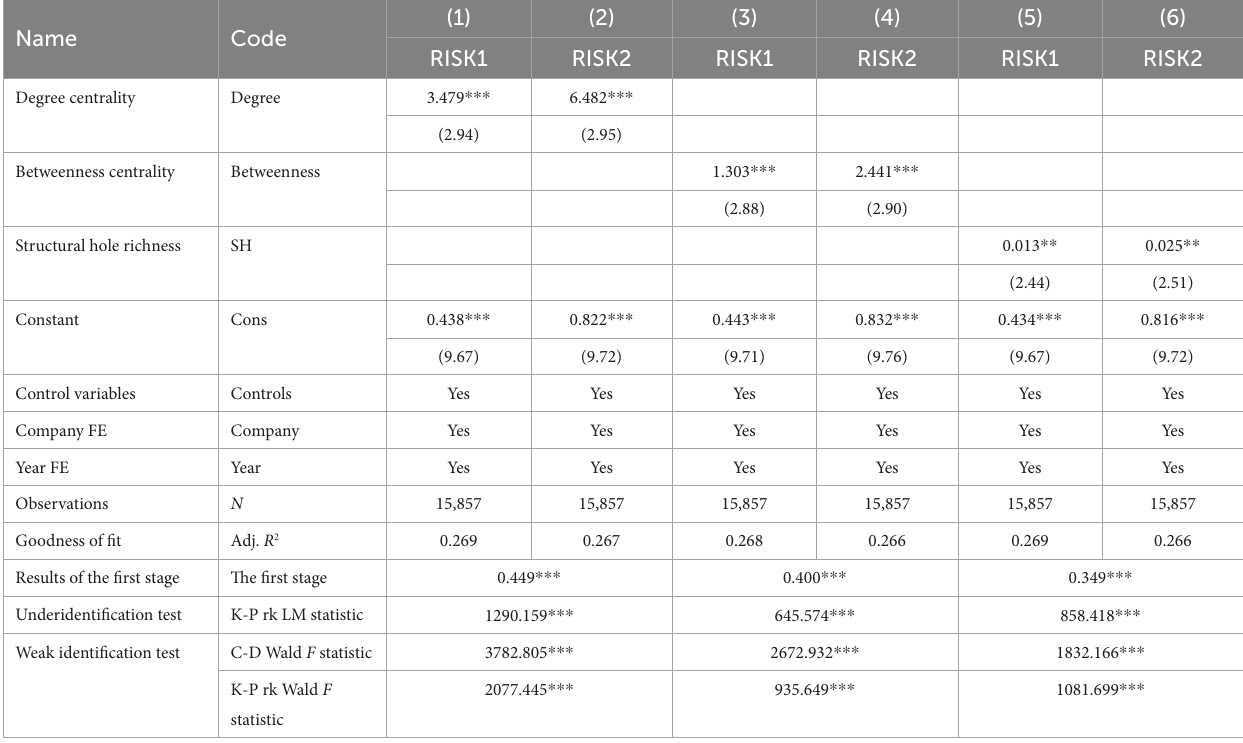
TABLE 5 Regression results of the two-stage least squares